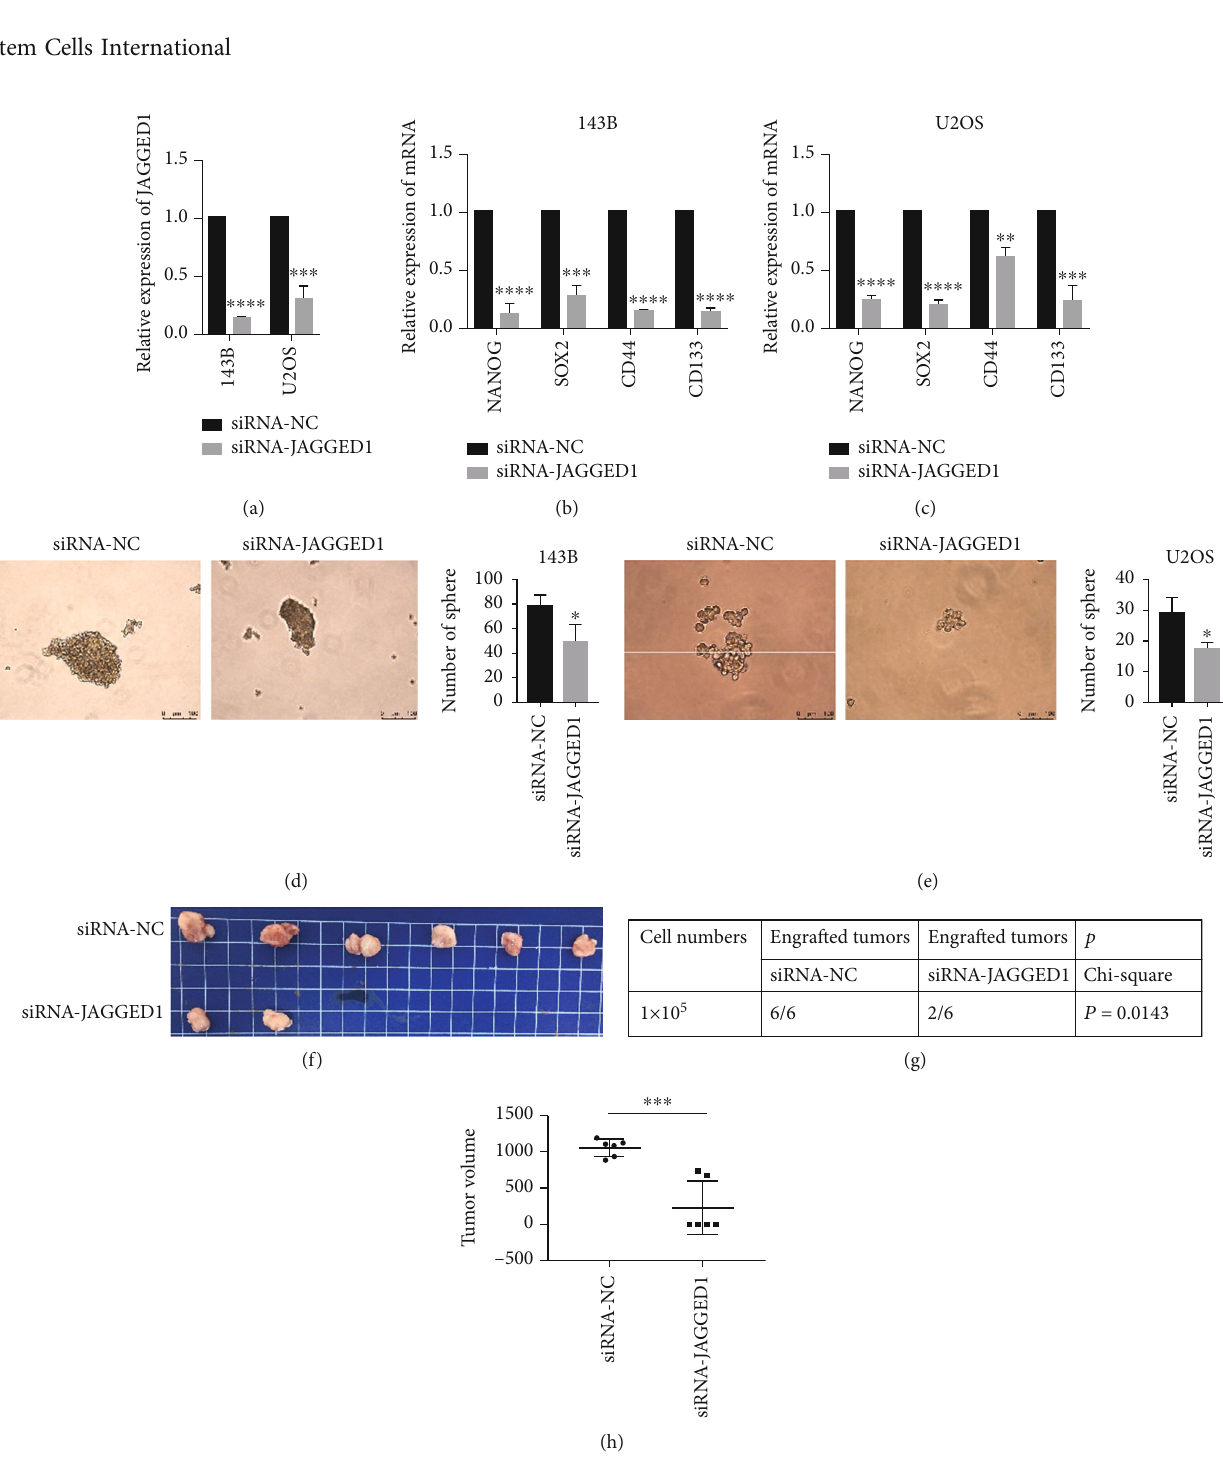
Figure 7: JAGGED1 downregulation inhibits the stem cell-like properties of osteosarcoma cells. (a) JAGGED1 knockdown reduced its mRNA expression. (b, c) JAGGED1 knockdown reduces stemness marker levels in osteosarcoma cells. (d, e) JAGGED1 knockdown inhibits the spheroidizing ability of osteosarcoma cells. (f – h) JAGGED1 knockdown inhibits tumor size and numbers in nude mice. ∗ p < 0 : 05 , ∗∗ p < 0 : 01 , ∗∗∗ p < 0 : 001 , ∗∗∗∗ p < 0 : 0001